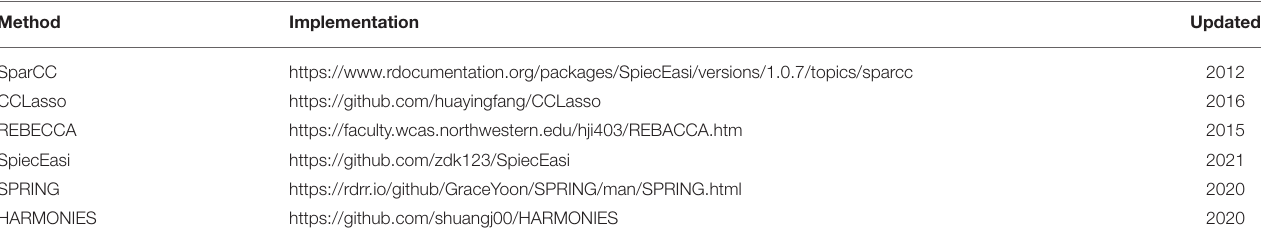
TABLE 9 | Implementation of methods for network analysis in microbiome